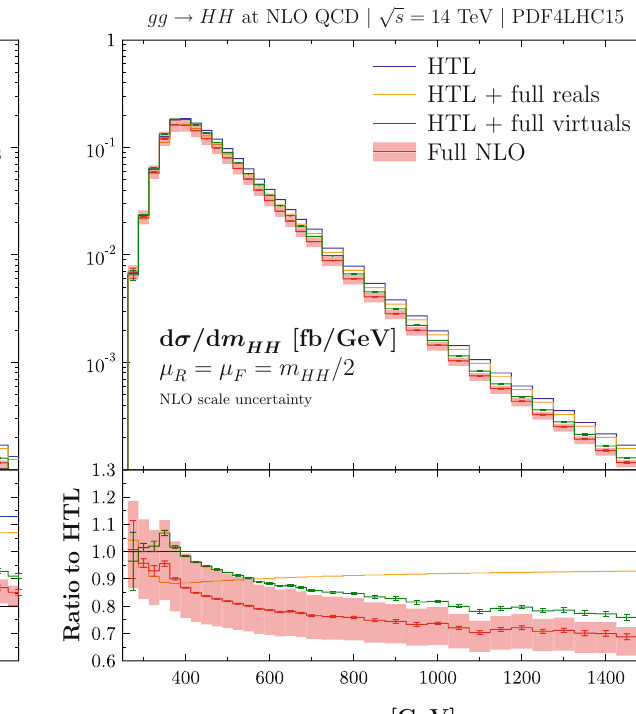
Left:Resultswiththe MMHT2014 PDFset,theinsertbelowdisplaysthe K -factors for the different results. Right: Results with the PDF4LHC15 PDF set, the insert below displays the ratio to the NLO HTL result for the different calculations. The red band indicates the renormalisation and factorisation scale uncertainties for results including the full NLO QCD